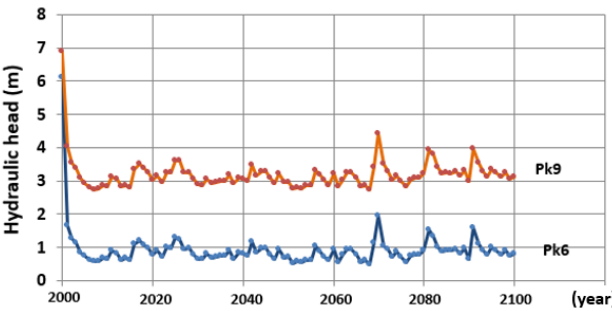
Figure A4. Concentrations variation at wells Pk6 and Pk9 under RCP scenario 4.5.